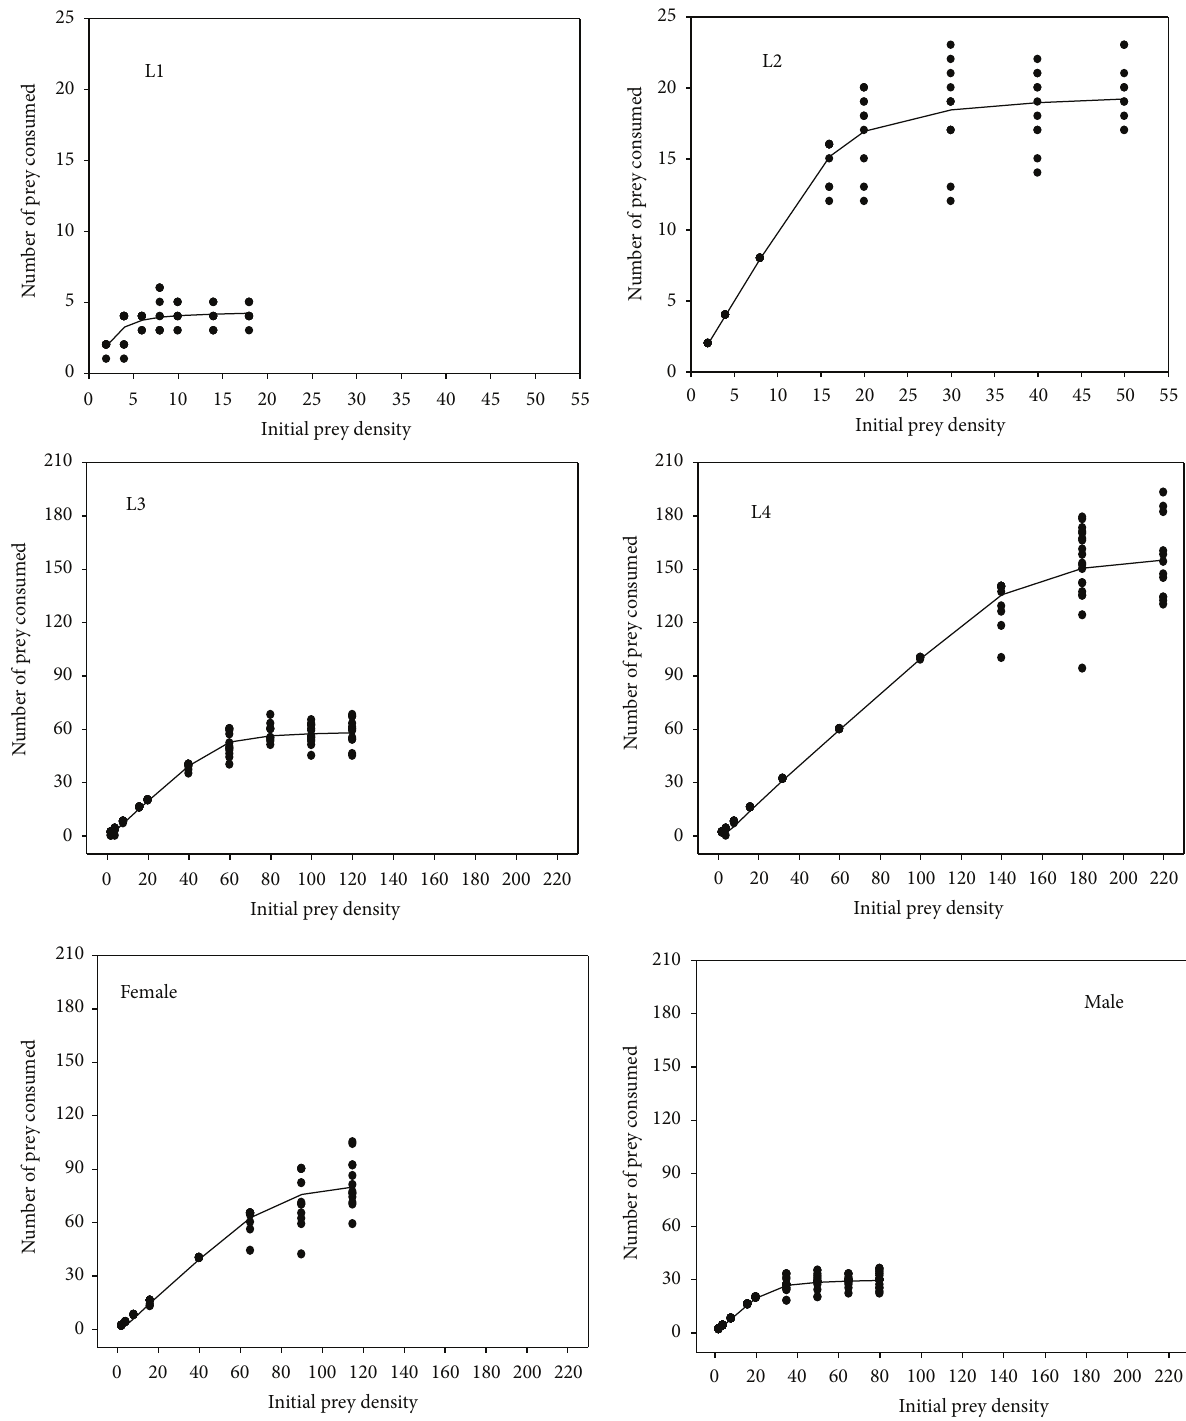
Figure 1: Functional responses of N. arcuatus to different densities of N. viridis . L1: 1st instar larva, L2: 2nd instar larva, L3: 3rd instar larva, L4: 4th instar larva: M: male, and F: female. Symbols are observed data and lines were predicted by